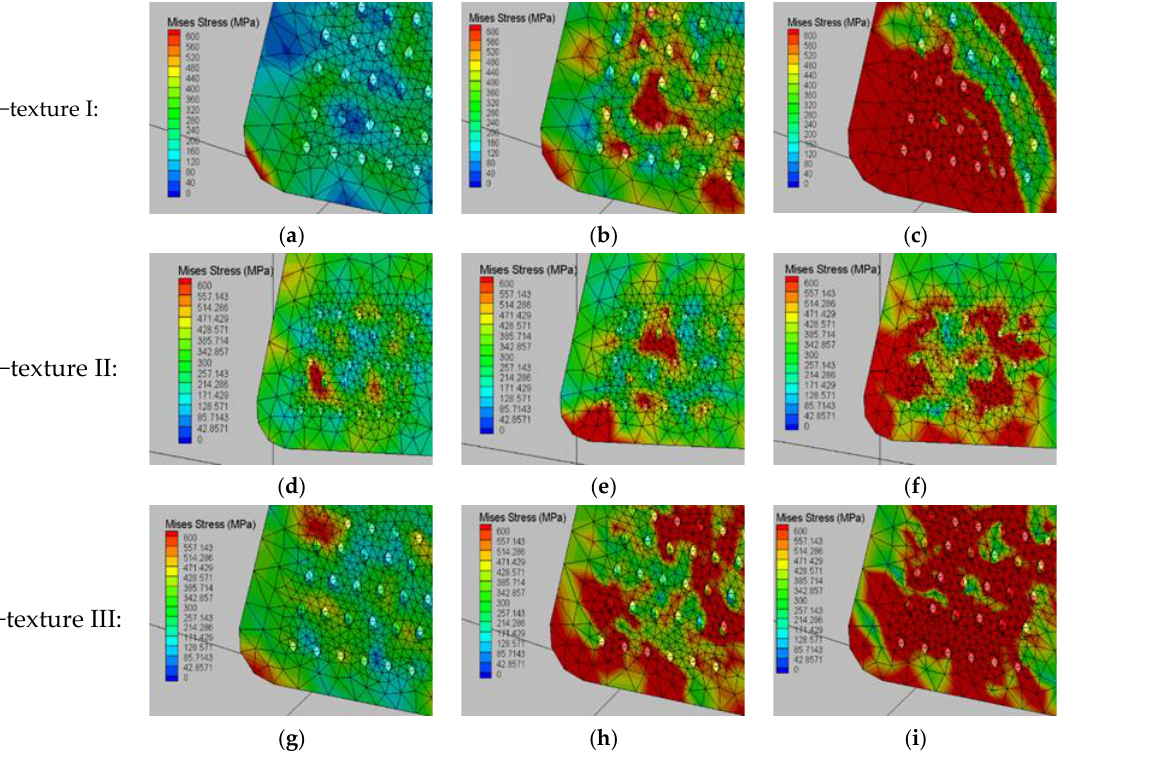
Figure 13. Stress distribution of three kinds of composite micro–texture tool. It can be seen from the above three kinds of composite micro–texture simulation experiments that the chip, cutting force and stress distribution can be significantly im- proved by using two tools of composite micro–texture combination, namely, the pit-convex interwoven micro–texture